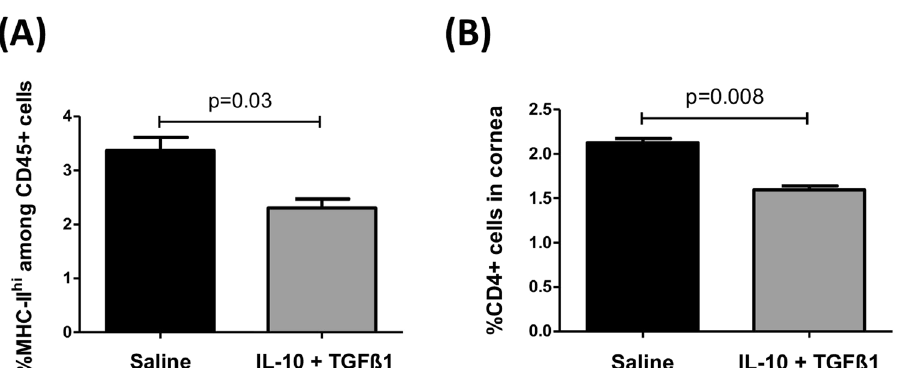
Figure 3. Treatment of donor corneas with IL-10 and TGF β 1 decreases infiltration of immune cells in the grafts. Two days after single subconjunctival injection of IL-10 and TGF β 1 or saline, corneas were transplanted on high-risk graft beds. Infiltration of leukocytes into the graft was determined 2 weeks after transplantation using flow cytometry. Corneal grafts were analyzed for frequencies of ( A ) MHCII + CD45 + cells and ( B ) CD4 + T cells. Bar graphs demonstrate mean ± SEM; N = 5 mice/group, data shown are representative of two independent